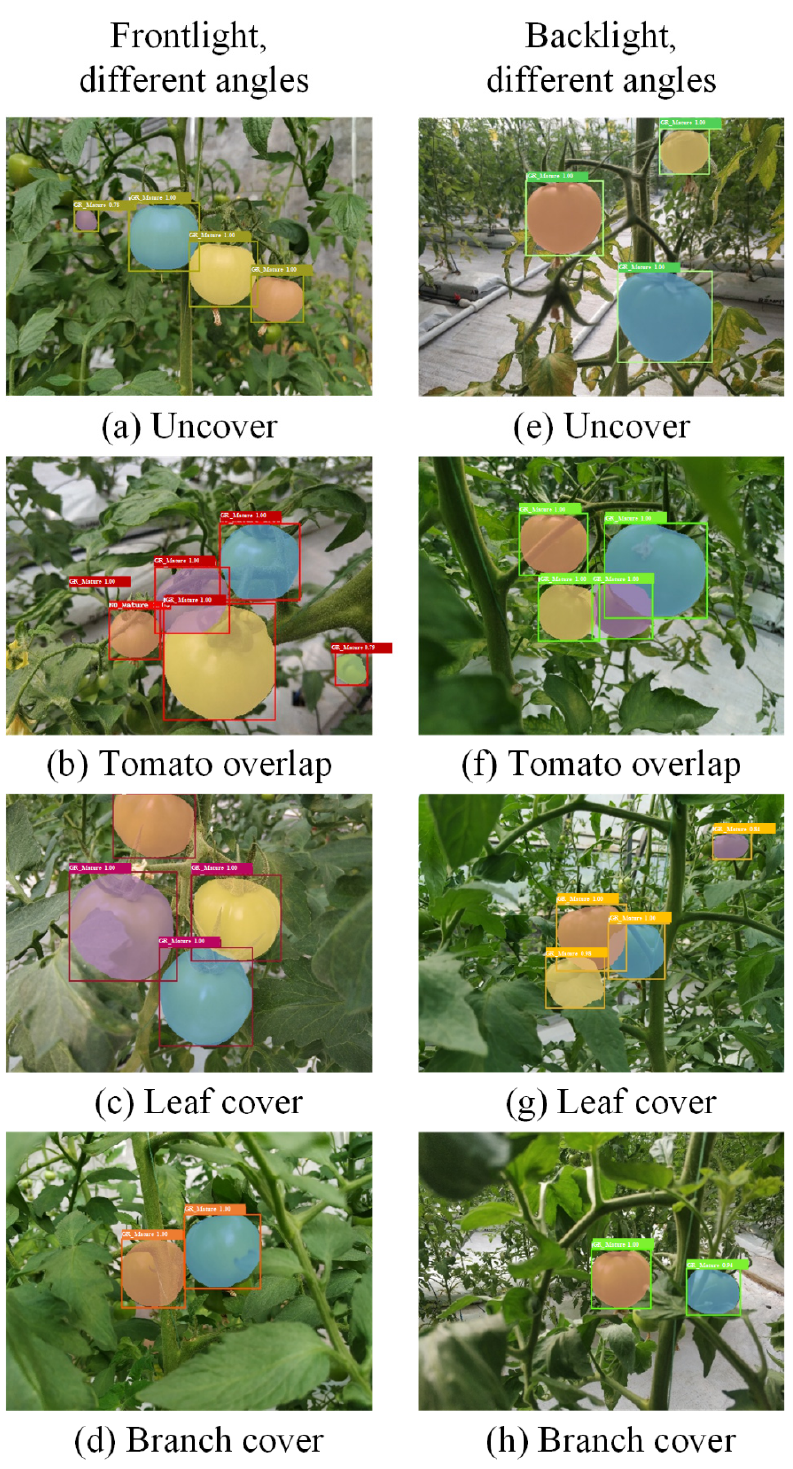
Figure 9. The detection and segmentation results of mature green tomatoes in different states.